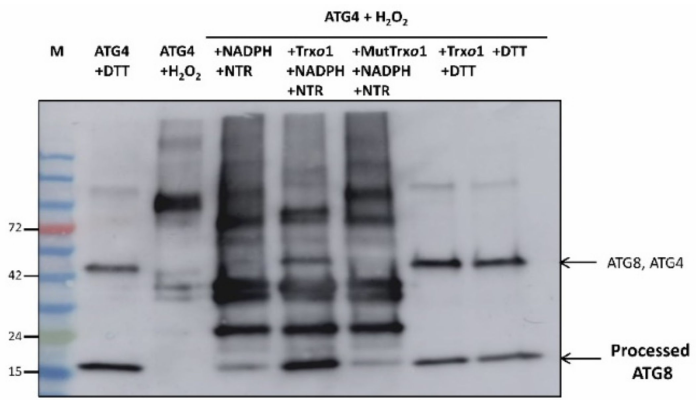
Figure 13. Regulation of ATG4 activity by oxidation and reduction by the TRX o 1 system. ATG4 activity was monitored by following the cleavage of recombinant quimeric His tag ATG8 substrate from the unprocessed to the processed pATG8 forms (indicated by arrowheads) by Western blot analysis using anti-His antibody. His tag HsATG4B was incubated with 15 µ M DTT (lane 2) and 1 mM of H 2 O 2 (lane 3). After oxidation with H 2 O 2 , the sample was reduced by the NADPH/TR/TRX o 1 system (lane 5) or NADPH/TR/MutTRX o 1 (TRX o 1C37S mutated variant, lane 6). Controls in the absence of TRX o 1 (lane 4) and reduction by DTT instead of TRX system (lanes 7 and 8) were also run (see material and methods section for details). Marker (M) proteins were loaded in lane 1 for molecular weight